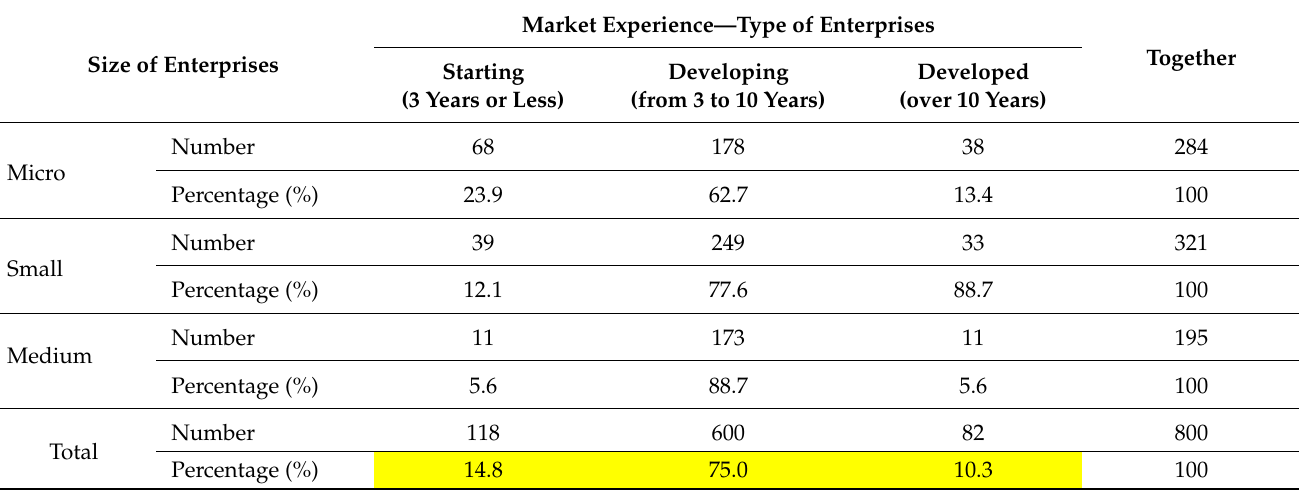
Table 4. Breakdown of the studied sample according to type of economic activity.